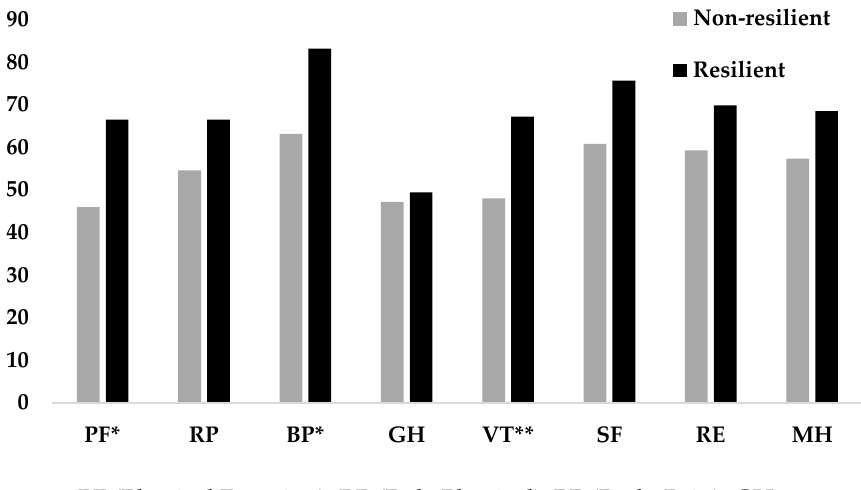
Figure 1. Differences in each domain of HRQOL between resilient and non-resilient participants (* p < 0.05; ** p < 0.01).